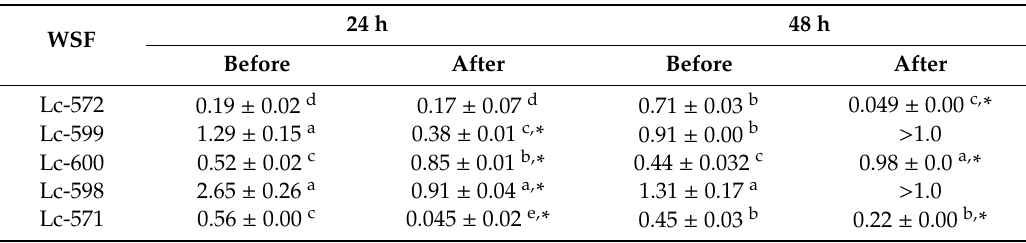
Table 1. IC 50 (mg / mL of peptide) values of inhibition of thrombin-induced fibrin polymerization by water soluble fraction (WSF) from fermented milk with L. lactis with 24 or 48 h of fermentation, before and after simulated gastrointestinal digestion (SGD). 24 h 48 h WSF Before After